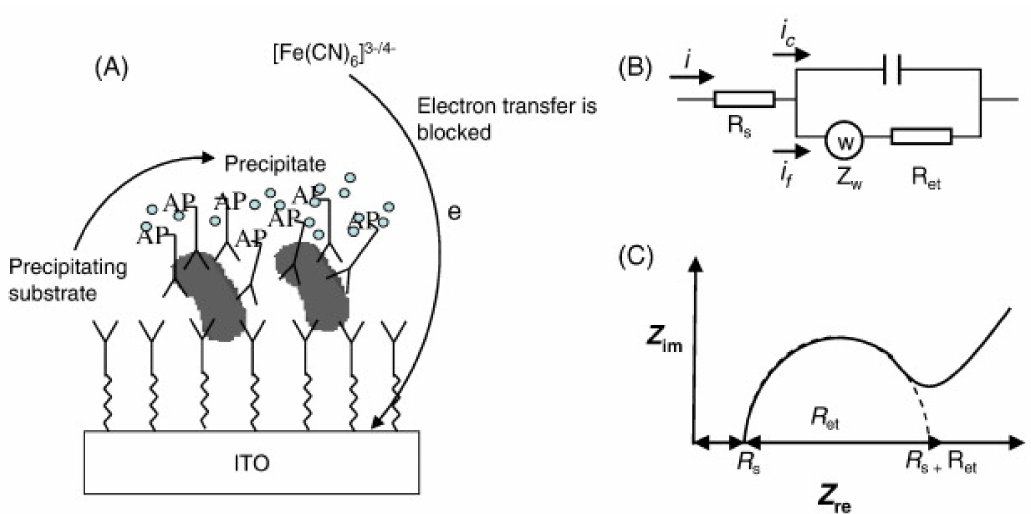
Figure 10. ( A ) The operating principle concerning the electrochemical impedance biosensor for bacteria quantification. ( B ) The Randles model equivalent circuit, and ( C ) the typical Nyquist plot (Z im vs. Z re ) of the Faradaic impedance spectrum of the electrochemical device when in the presence of the redox probe. Reproduced and reprinted with permission from